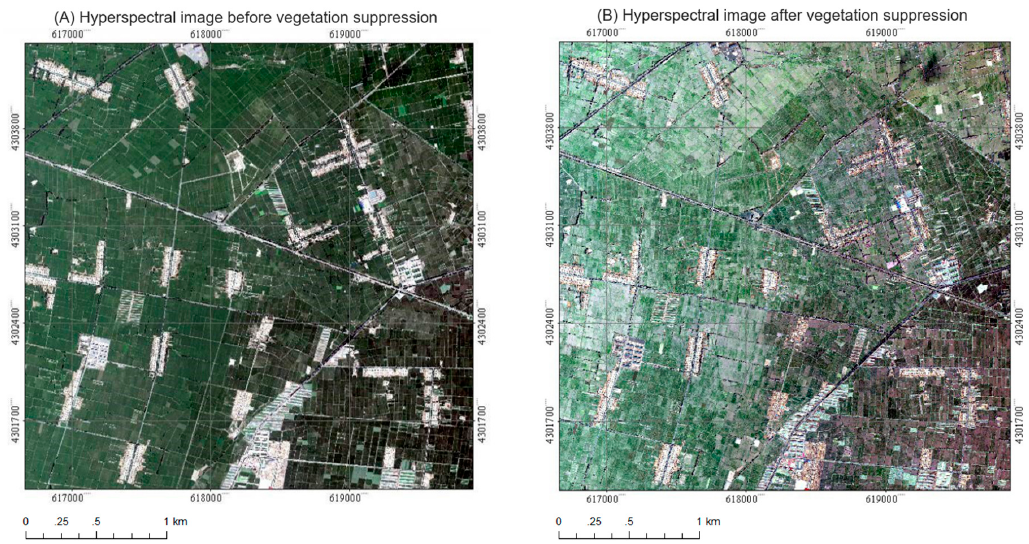
Figure 5. Comparison of airborne hyperspectral true colour images (R: 640.5 nm, G: 554.7 nm B: 468.7 nm) before ( A ) and after vegetation suppression ( B ).